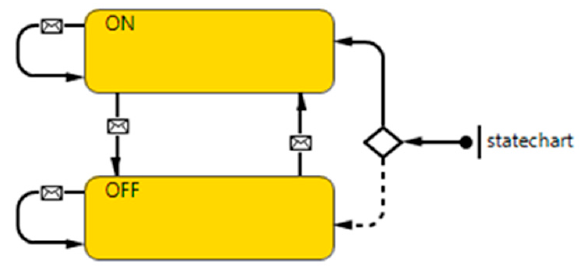
Figure 5. Refrigeration-unit operating